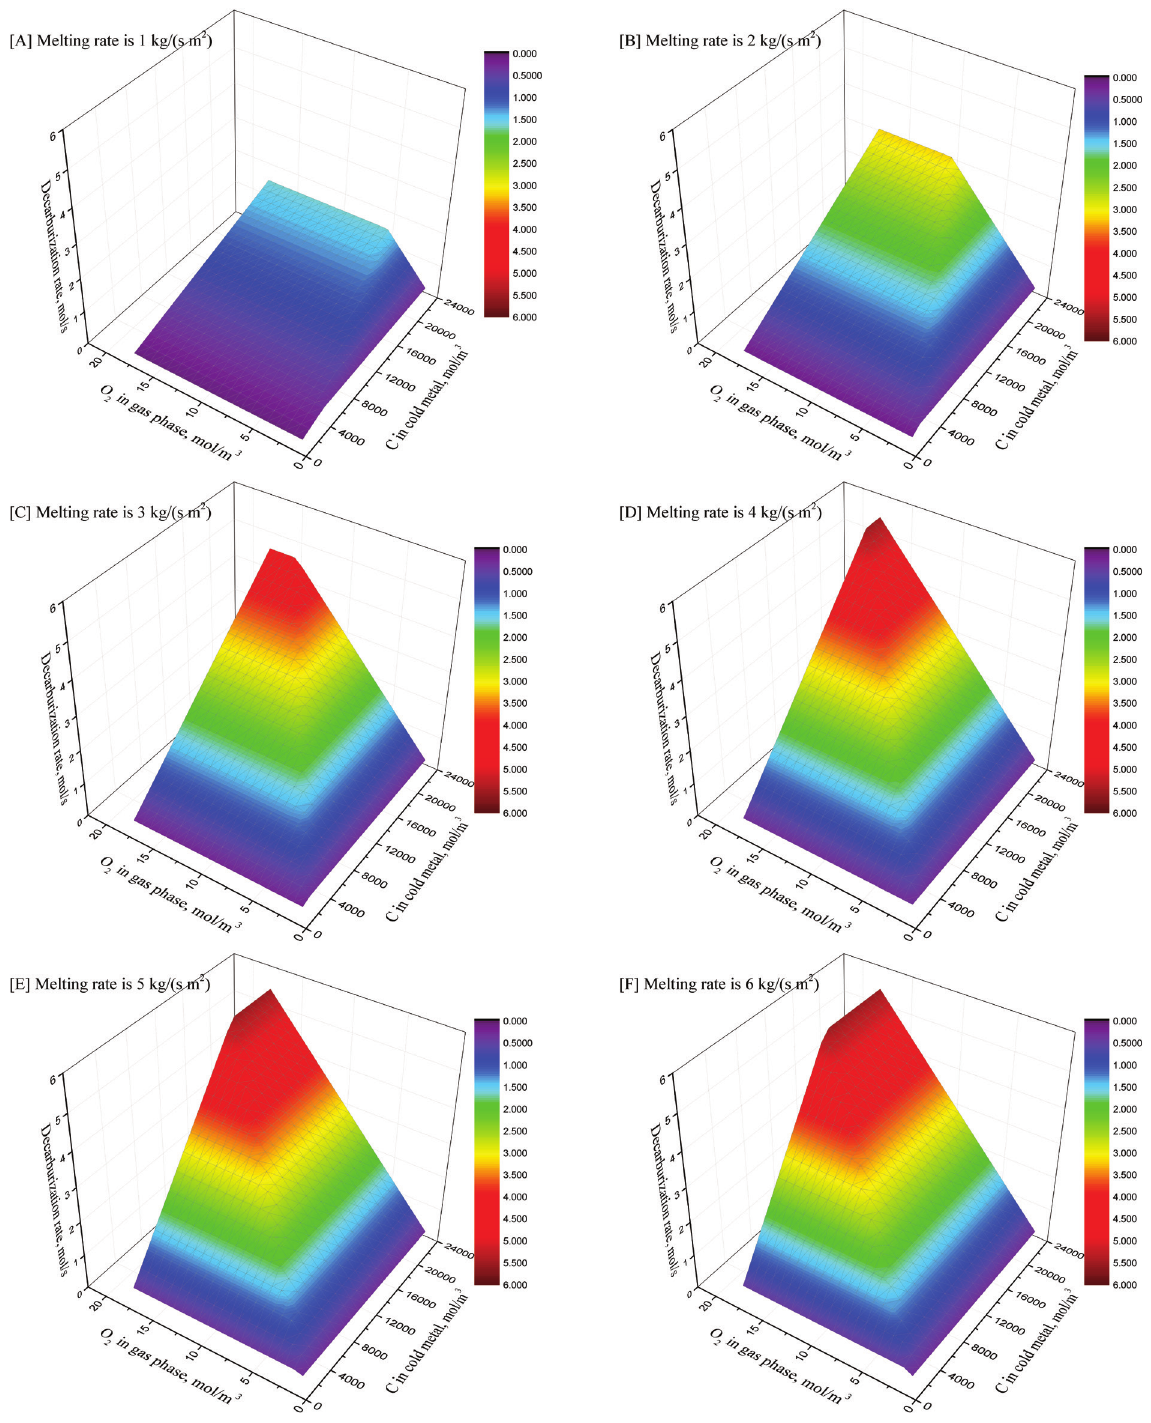
Fig. 5: Relationships between decarburization rates and concentrations of O 2 in gas phase and C in solid metal at different melting